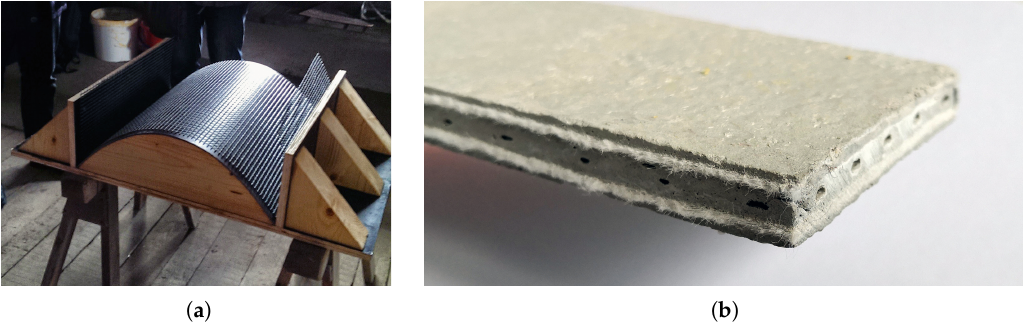
Figure 3. Girder cross section: ( a ) profile of the girder with the carbon fabric reinforcement; ( b ) cross-sectional layup consisting of carbon reinforced concrete in the middle section and fleece concrete composite at the top and at the bottom.